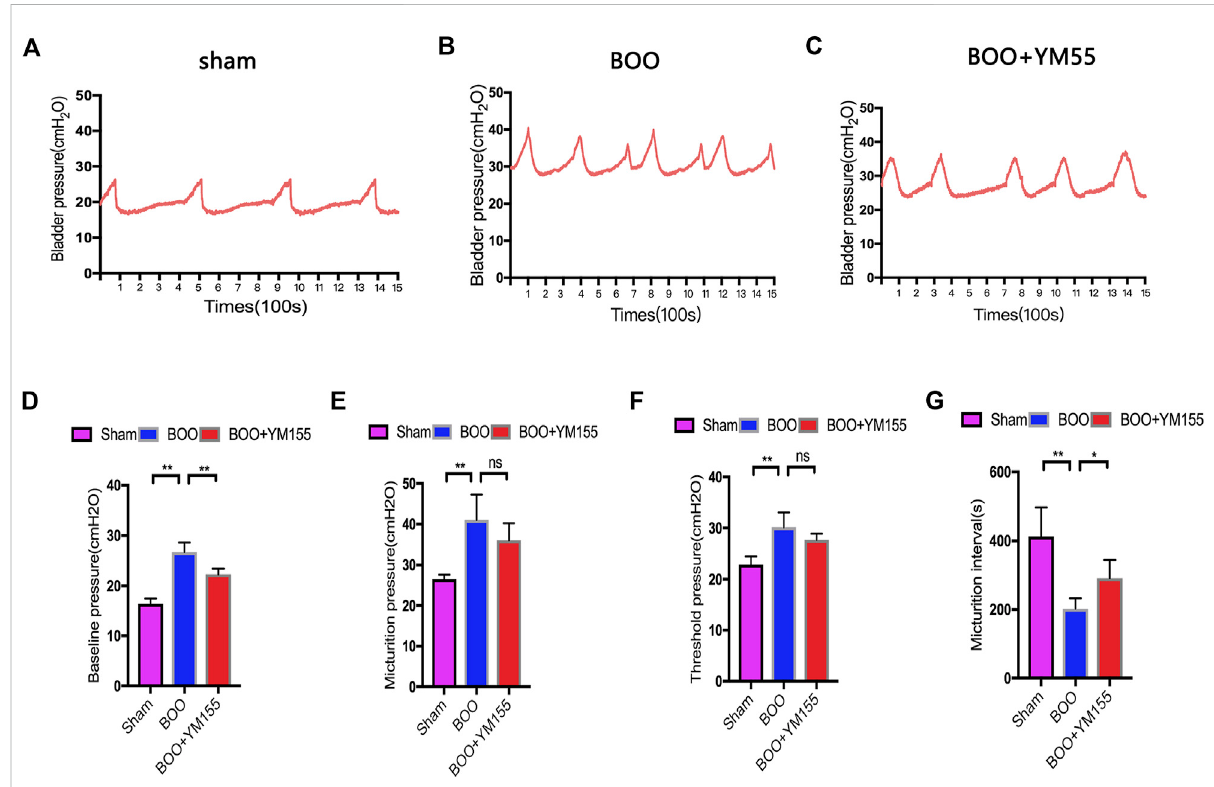
FIGURE 3 TheeffectofYM155onBOO-inducedbladderdysfunction. (A) Theurodynamiccurveofsham-operatedrats. (B) TheurodynamiccurveofBOO rats. (C) TheurodynamiccurveofBOOratsthatwereadministeredwithYM155. (D) Baselinepressure, (E) micturitionpressure, (F) thresholdpressure, and (G) micturition interval in the three groups. Data are presented as the mean ± SD, n = 8. ** p < 0.01; * p < 0.05;